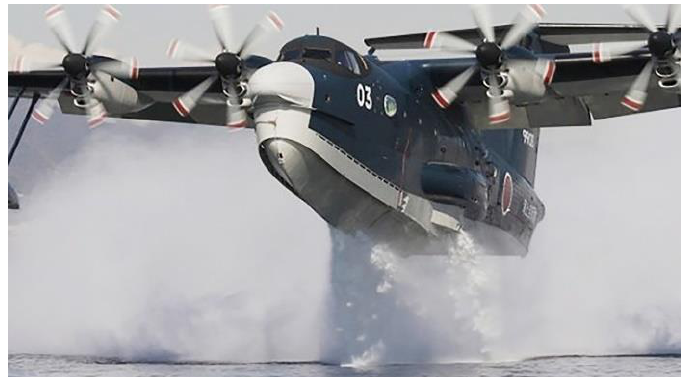
Figure 1. Takeoff of amphibious plane on water.